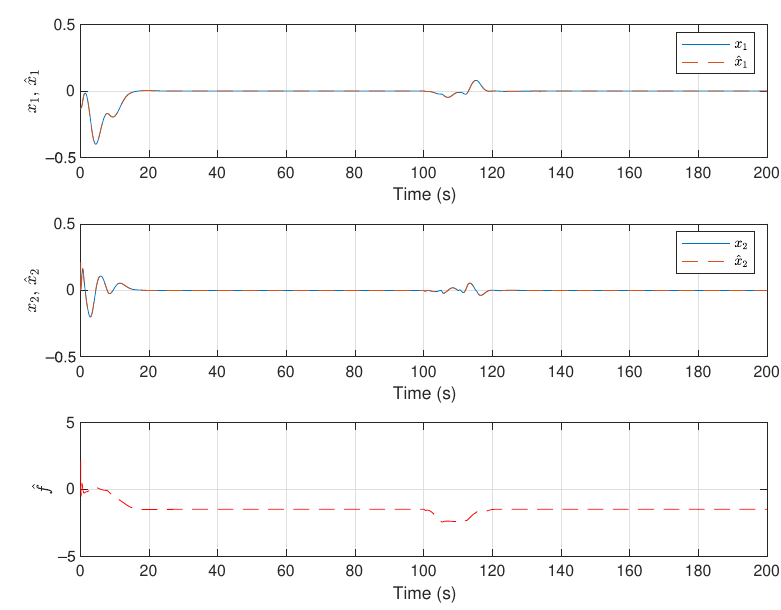
Figure 4. Observed results of